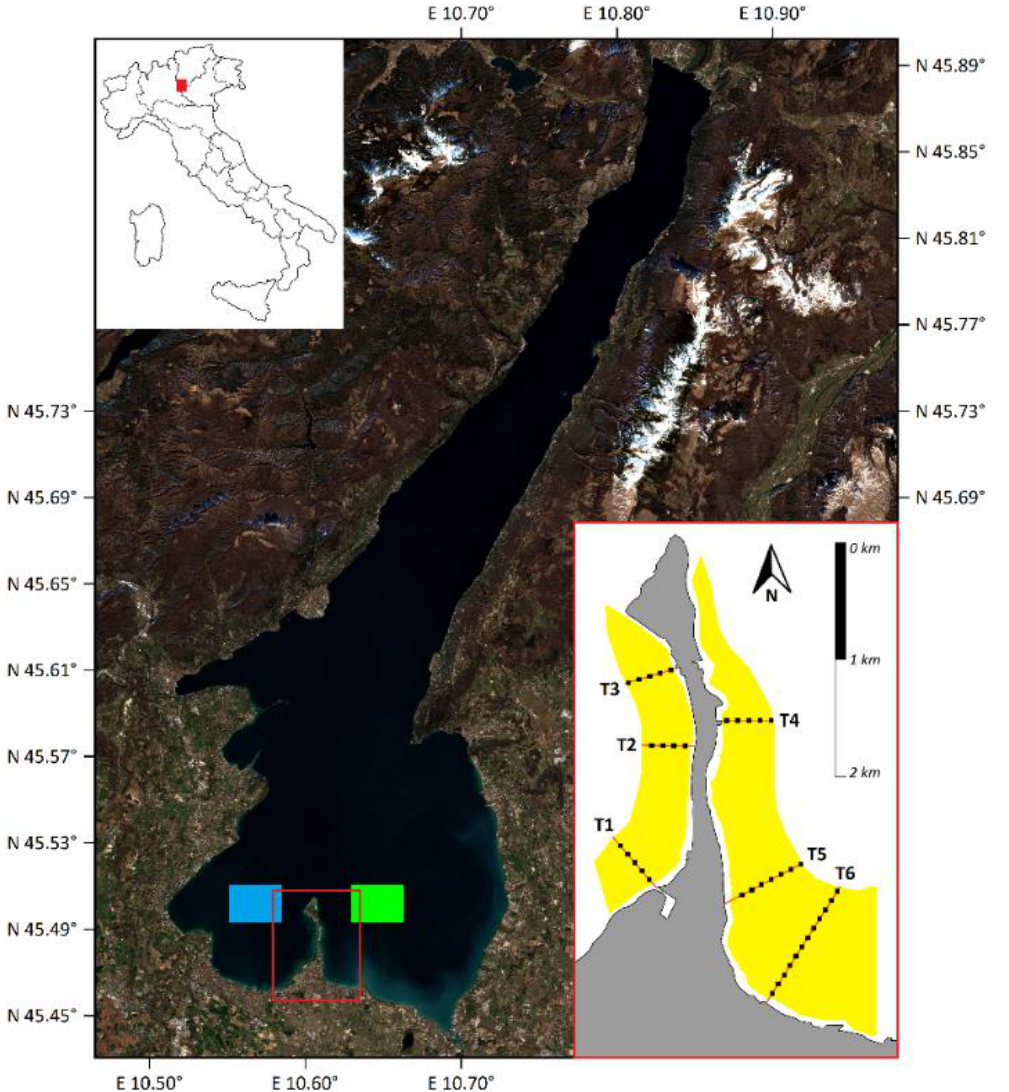
Figure 1. Sentinel-2 image of Lake Garda in true color (23/03/2019). Above on the left is the location of Lake Garda in Italy. The blue and green rectangles represent the two areas analyzed to extract turbidity values (NTU). The red box represents the study area (Sirmione Peninsula). Below on the right shows an enlargement of the Sirmione Peninsula (grey): the yellow area represents the mask used to create the bottom coverage maps (3.97 km 2 ), while the lines with black squares represent the transects used for assessing the macrophytes gradients from the coast.